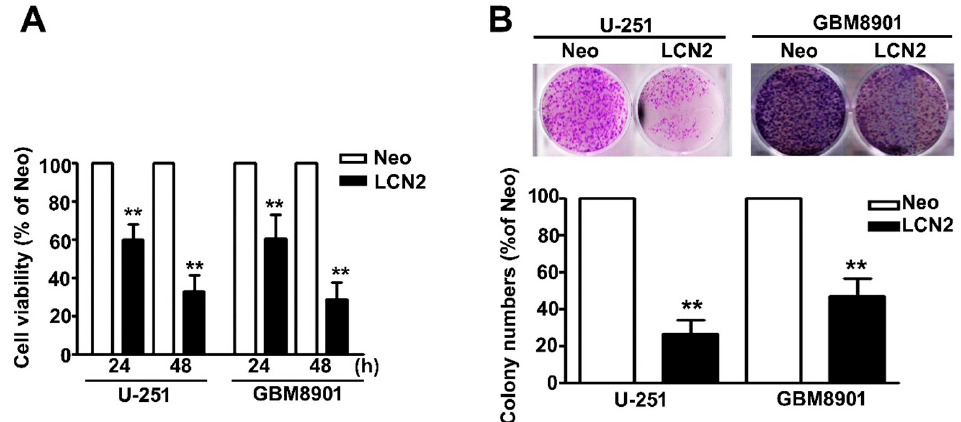
Figure 2. Effects of LCN2 on the cell viability and proliferation of GBM cells ( A ) Viability of LCN2- or Neo-expressing GBM8901 and U-251 cells as determined by MTT assay and ( B ) colony-forming assay. The values are expressed as the mean ± SE of at least three independent experiments. ** p < 0.01 compared with that of Neo cells.